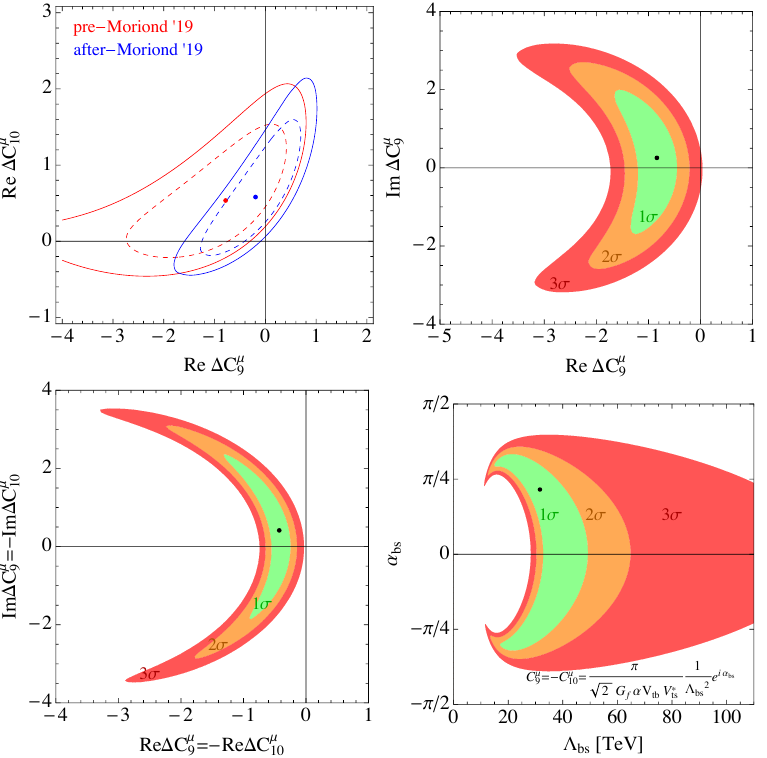
Figure 8 . 2D (cid:12)ts of the clean bs(cid:22)(cid:22) observables listed in table 1. In the top-left panel the dots represent the best-(cid:12)t points while dashed (solid) lines are 95%CL (99%CL) contours. In the other panels the black dot is the best-(cid:12)t point and the green, orange, and red regions are such that (cid:1) (cid:31) 2 (cid:20) 2.28 (68%CL), 5.99 (95%CL), and 11.6 (99%CL),